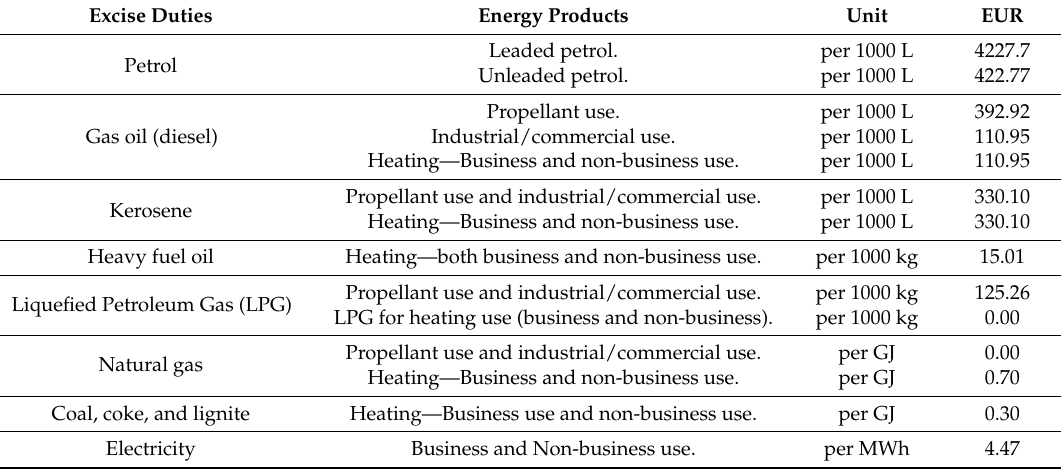
Table 1. Excise duties in Estonia, 2015